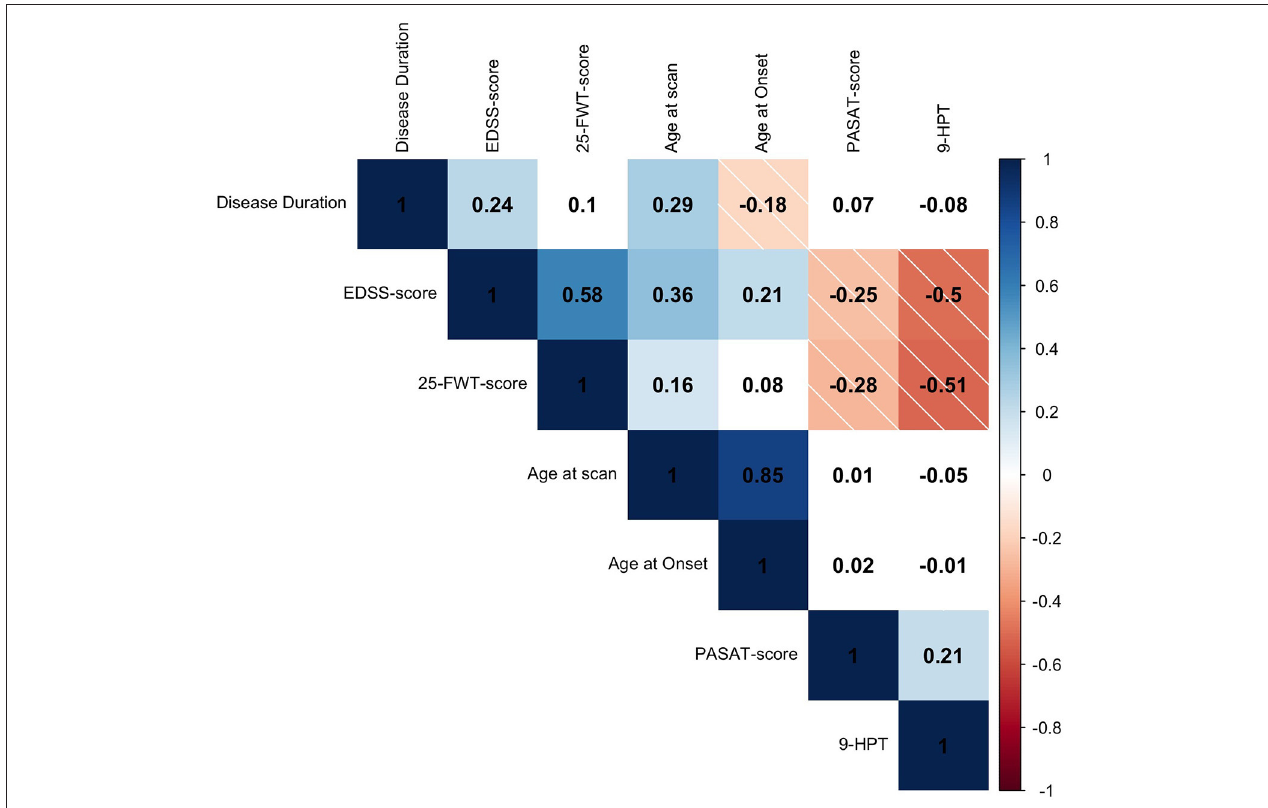
FIGURE 1 | Spearman’s rho (r s ) correlation matrix of clinical variables. Positive correlations are depicted in solid blue and negative correlations are depicted in striped red. The color intensity is proportional to the correlation coefficient. White fields are displaying non-significant relationships ( p > 0.05). The r s is given in every field.